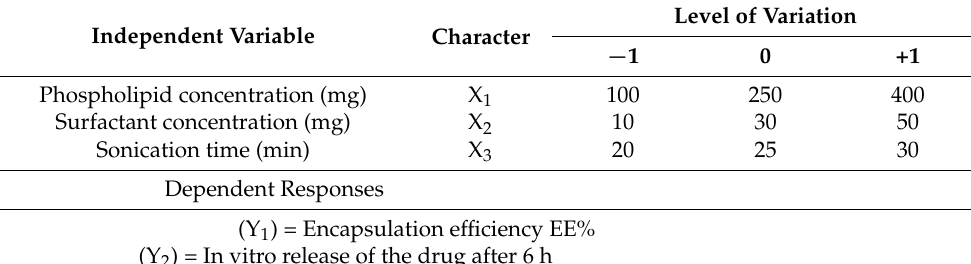
Table 1. Variables of Box–Behnken design for Silymarin transfersomes formulations showing inde- pendent variables and their level of variation. Level of Variation Independent Variable Character − 1 0 +1 Phospholipid concentration (mg) X 1 100 250 400 Surfactant concentration (mg) X 2 10 30 50 Sonication time (min) X 3 20 25 30 Dependent